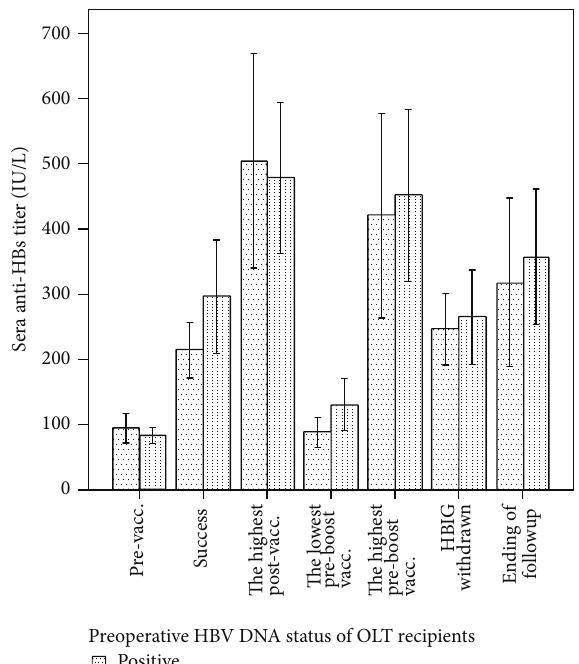
Figure 5: There were no significant differences between the ≥ 10 3 copies/mL group and the < 10 3 copies/mL group in baseline anti-HBs titer, titer at successful establishment of immunity, the highest titer after vaccination, the lowest titer before booster vacci- nation,thehighesttiterafterboostvaccination,titerwhenHBIGwas withdrawn, and the titer at the end of followup (vacc.: